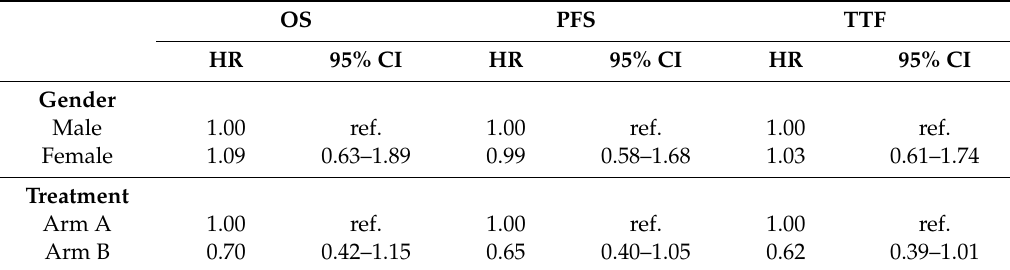
Table 2. Multivariate analysis (only corrected for gender).